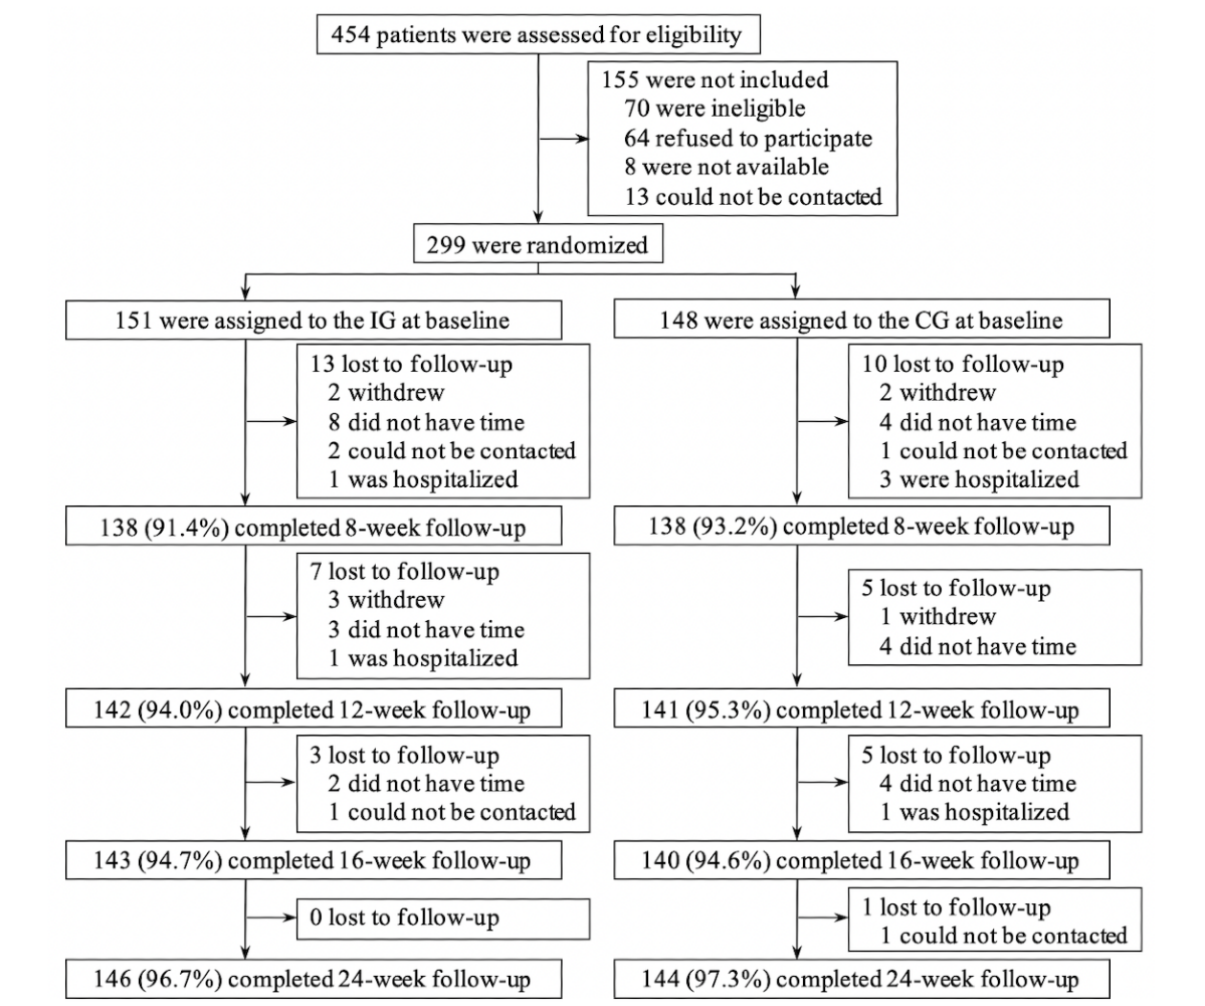
Figure 1. Trial flowchart. CG: control group; IG: intervention